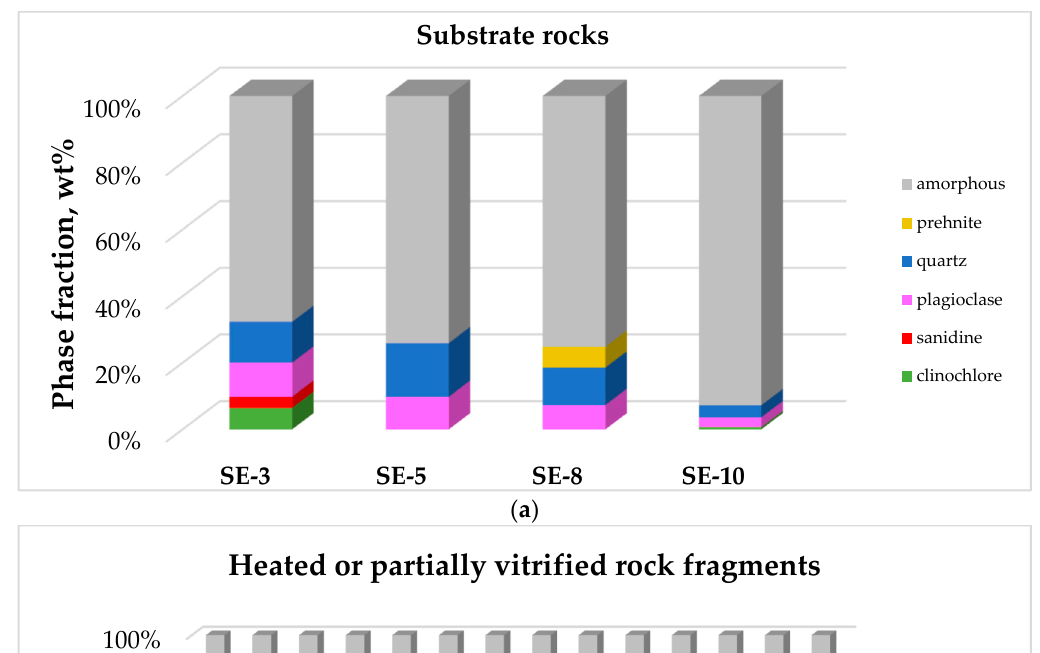
SE 15 (Table 2) confirms that the samples were subjected to chemical decomposition due to weathering effects.